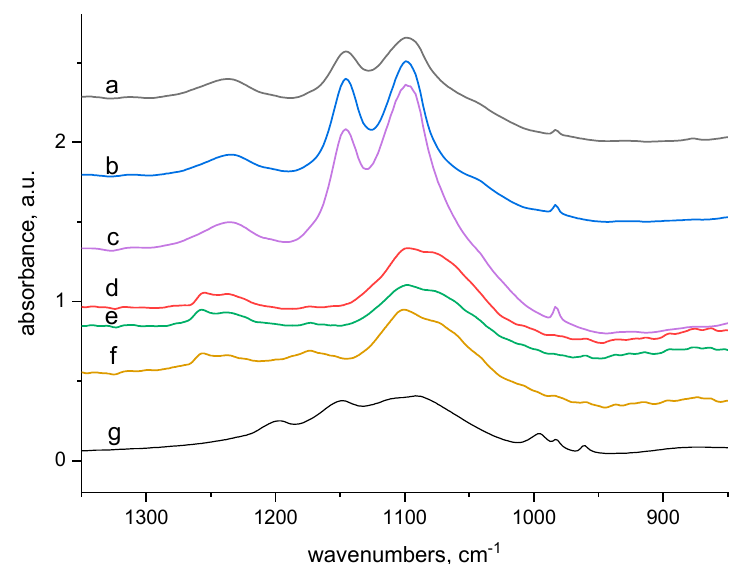
Figure 2. Comparison of the transmission and ATR spectra of wool with absorbed doses 0 kGy, 24 kGy and 165 kGy respectively after contact with 100 mmol·dm − 3 CuSO 4 solution (region 900–1300 cm − 1 ); from top to bottom: (a), (b) and (c) transmission spectra of 0 kGy, 24 kGy and 165 kGy dosed samples; (d), (e) and (f)—ATR spectra of 0 kGy, 24 kGy and 165 kGy dosed samples, g)—spectrum of CuSO 4 .